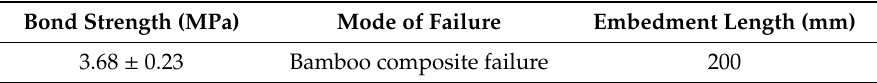
Table 6. Bond strength values for bamboo composite